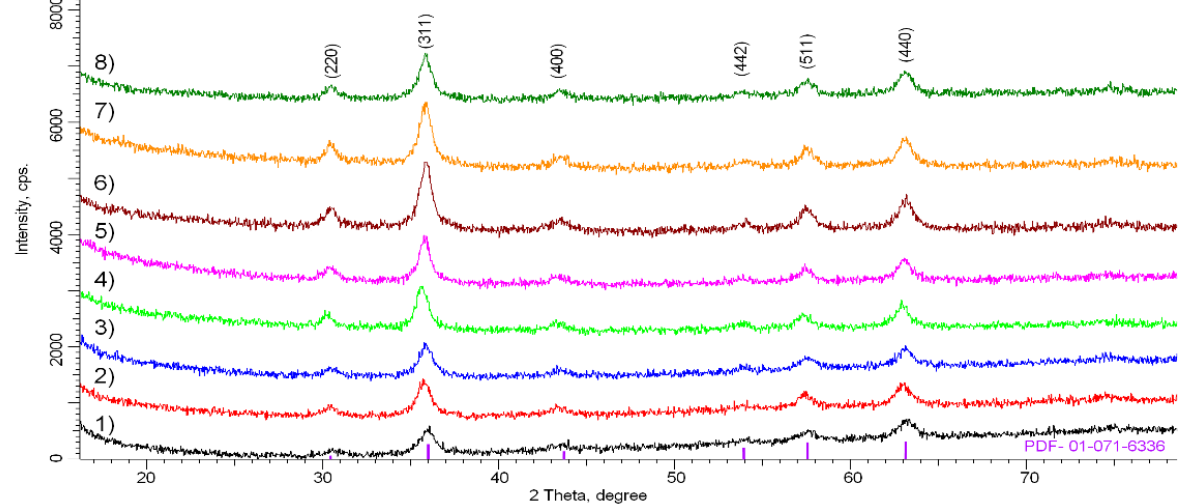
Figure 4. X-ray diffraction of Fe 3 O 4 at different stages of modification: Fe 3 O 4 (1), Fe 3 O 4 -TMSPM (2), Fe 3 O 4 -TMSPM-PAA (3), Fe 3 O 4 -TMSPM-PAA/PALAm (4), Fe 3 O 4 -TMSPM-PAA/PALAm-Gd (5), Fe 3 O 4 -TMSPM-PAA/PALAm-Gd-PAA (6), Fe 3 O 4 -TMSPM-PAA/PALAm-Gd-PAA/PALAm (7), Fe 3 O 4 -TMSPM-PAA/PALAm-Gd-PAA/PALAm-Carborane (8).